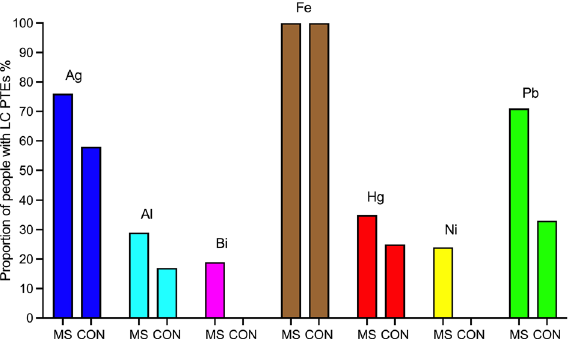
Figure 10. The proportion of people with potentially toxic elements (PTEs) detected in the locus ceruleus with LA-ICP-MSI. All individuals had iron in the locus ceruleus. Similar proportions of MS patients and controls (CON) had silver and mercury in the locus ceruleus, while slightly more MS patients had locus ceruleus aluminium and lead. Bismuth and nickel were present in the locus ceruleus of a few MS patients, but not in